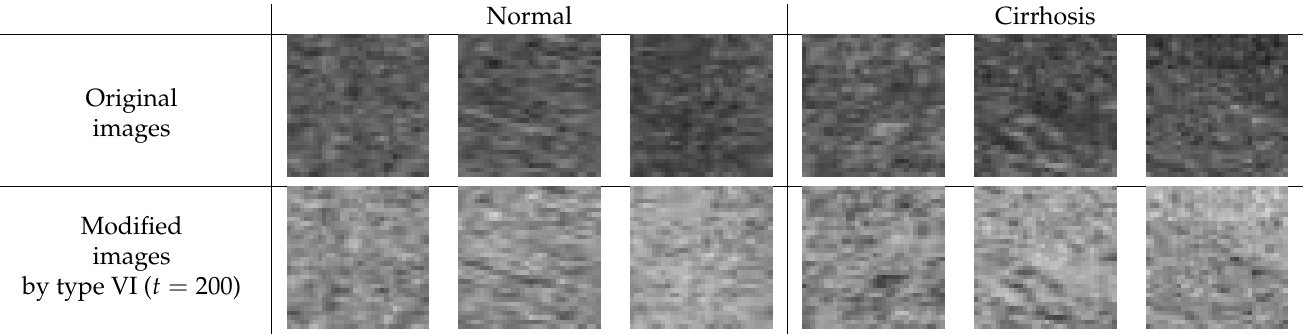
Figure 7. Difference between the original and the modified ROI image for normal and cirrhosis